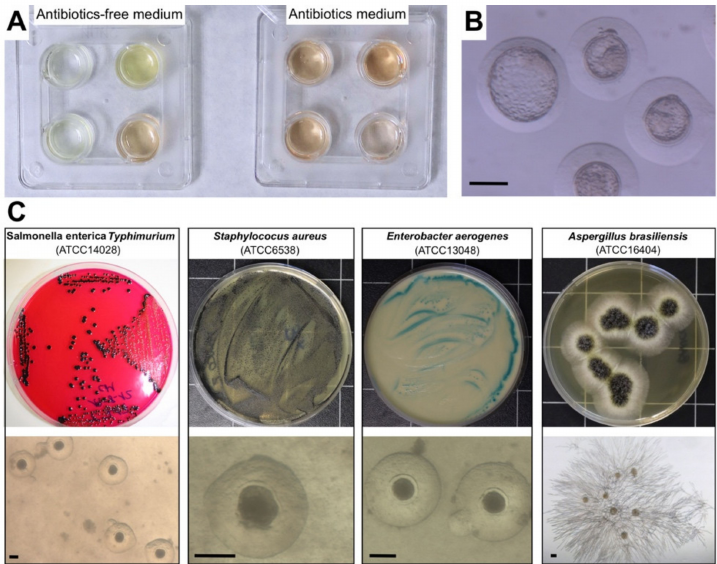
Figure 2. Representative images of microorganism viability. ( A ) Plates containing medium after embryo culture for 48 h in antibiotic- and antimycotic-free medium (left) and in antibiotic and antimycotic medium (right). ( B ) Non-infected vitrified-thawed embryos cultured for 48 hours in antibiotic- and antimycotic-free medium. ( C ) Representative sample image of positive plates after inoculated 100 µ L of culture medium on selective media and vitrified-thawed embryos cultured for 48 hours in antibiotic- and antimycotic-free medium. S. Typhimurium sample cultured onto XL. S. aureus sample cultured onto Baird Parker Agar. T-4 Agar. E. aerogenes sample cultured onto Cetrimide Agar. A. brasiliensis sample cultured onto Sabouraud Chloramphenicol Agar. Scale bar: 150 µ